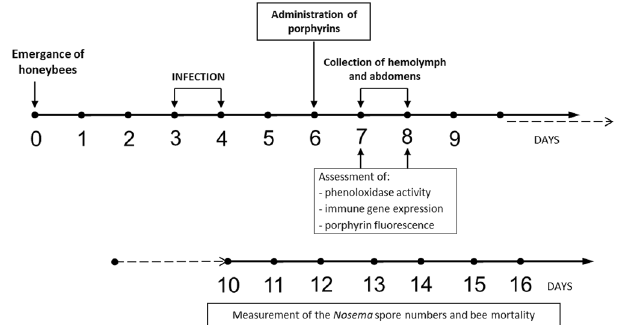
Figure 1. Flowchart of the experiments analyzing the effect of protoporphyrin IX derivatives on Apis mellifera humoral immune response, number of Nosema ceranae spores in bees, and bee